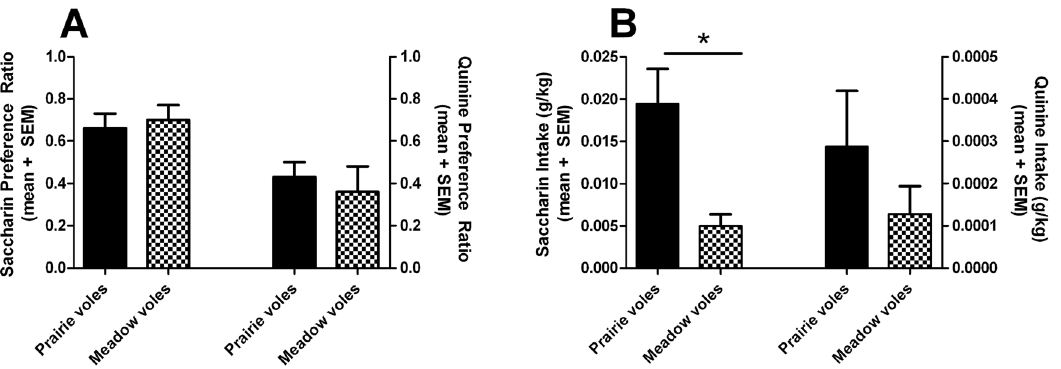
Figure 3. Consumption of tastants saccharin and quinine. There was no difference between species in tastant preference (A). There was a significant difference between species in tastant consumption, where meadow voles consumed less saccharin, but not quinine, than prairie voles (B). Values indicate group mean + standard error of the mean (SEM). * effect of species; p , 0.05